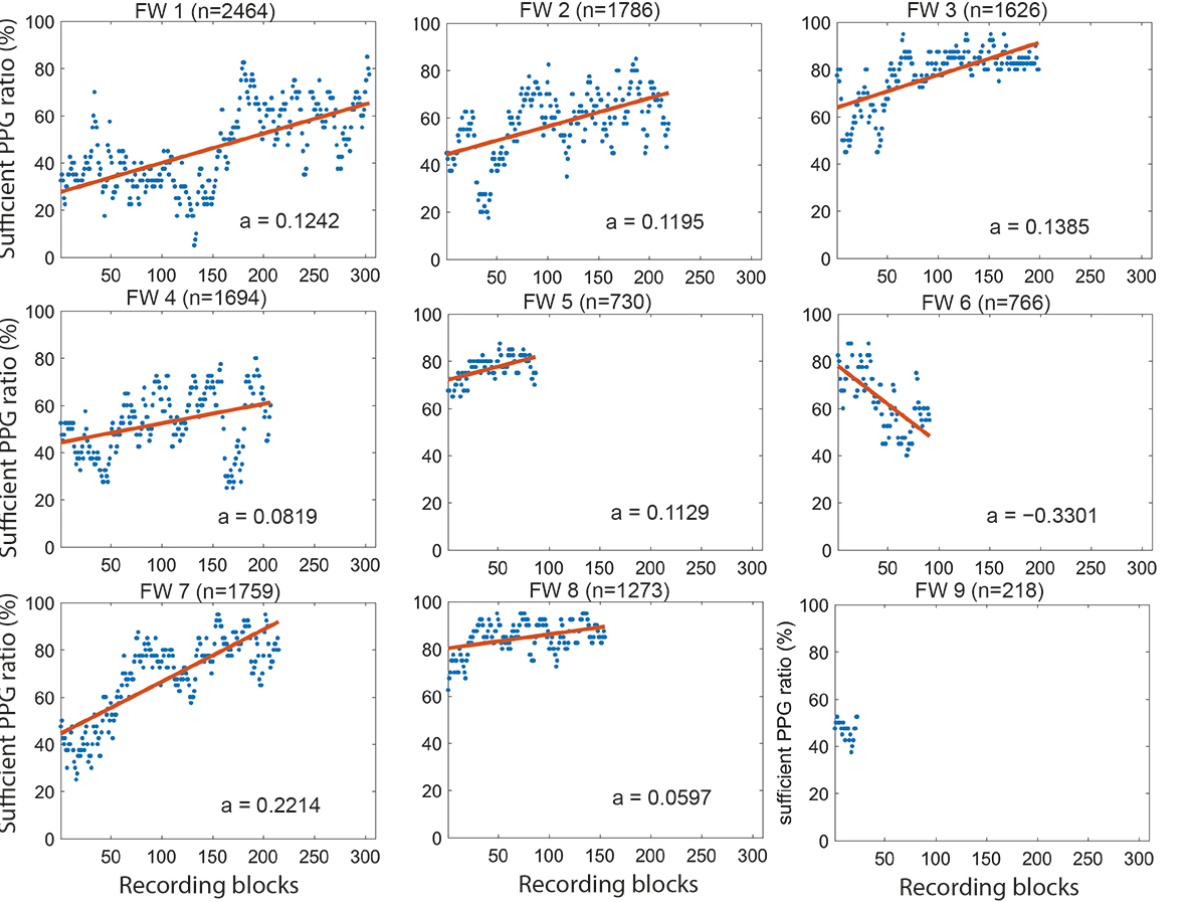
Figure 3. “Sufficient” photoplethymogram quality ratio over recording blocks for all 9 field workers (field worker 1-9 [n=number of photoplethymogram recordings performed]) during the trial. The blue dots depict the ratios between number of “sufficient” photoplethymogram signals and total number of photoplethymogram signals within each recording block (40 consecutive recordings with a step size of 8) by each field worker and the red trend lines are the linear fit of the ratios estimating the trend of recording quality (a=slope of trend line). Field worker 9 did not produce sufficient recordings for meaningful trend estimation and was not included in the signal quality analysis. FW: field worker; PPG: